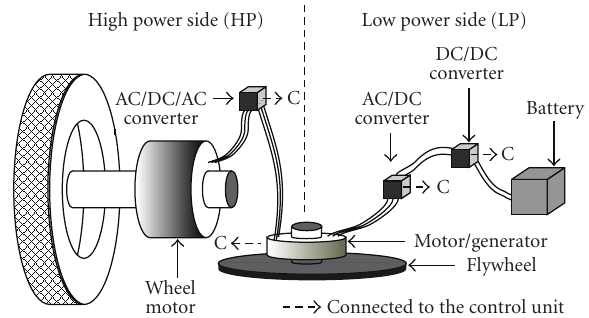
Figure 1: EV propulsion system based on a flywheel energy storage device with two power